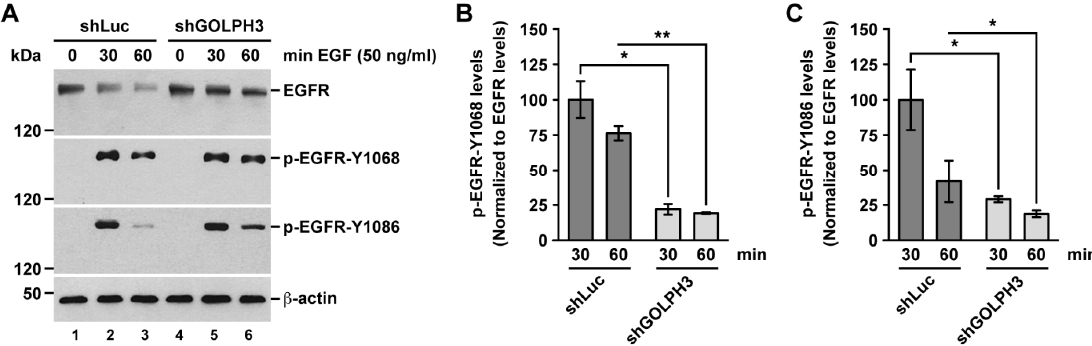
Figure 9. The knockdown of GOLPH3 in T98G cells impairs ligand-induced activation of EGFR. ( A ) The indicated cells grown in 6-well plates were incubated with EGF for the indicated periods of time. Detergent-soluble extracts were prepared from cells and samples of proteins were analyzed by SDS-PAGE followed by immunoblotting using antibodies to detect the proteins indicated on the right, including antibodies specific to EGFR phosphorylated either at Tyr1068 (p-EGFR-Y1068) or Tyr1086 (p-EGFR-Y1086). The immunoblot signal of anti- β -actin was used as a loading control. The position of molecular mass markers is indicated on the left. ( B , C ) Densitometry quantification of the ratio between the immunoblot signals for p-EGFR-Y1068 and total EGFR ( B ) or p-EGFR-Y1086 and total EGFR ( C ) from images as those shown in A. Bars represent the mean ± standard deviation ( n = 3; * p < 0.05; ** p < 0.01).